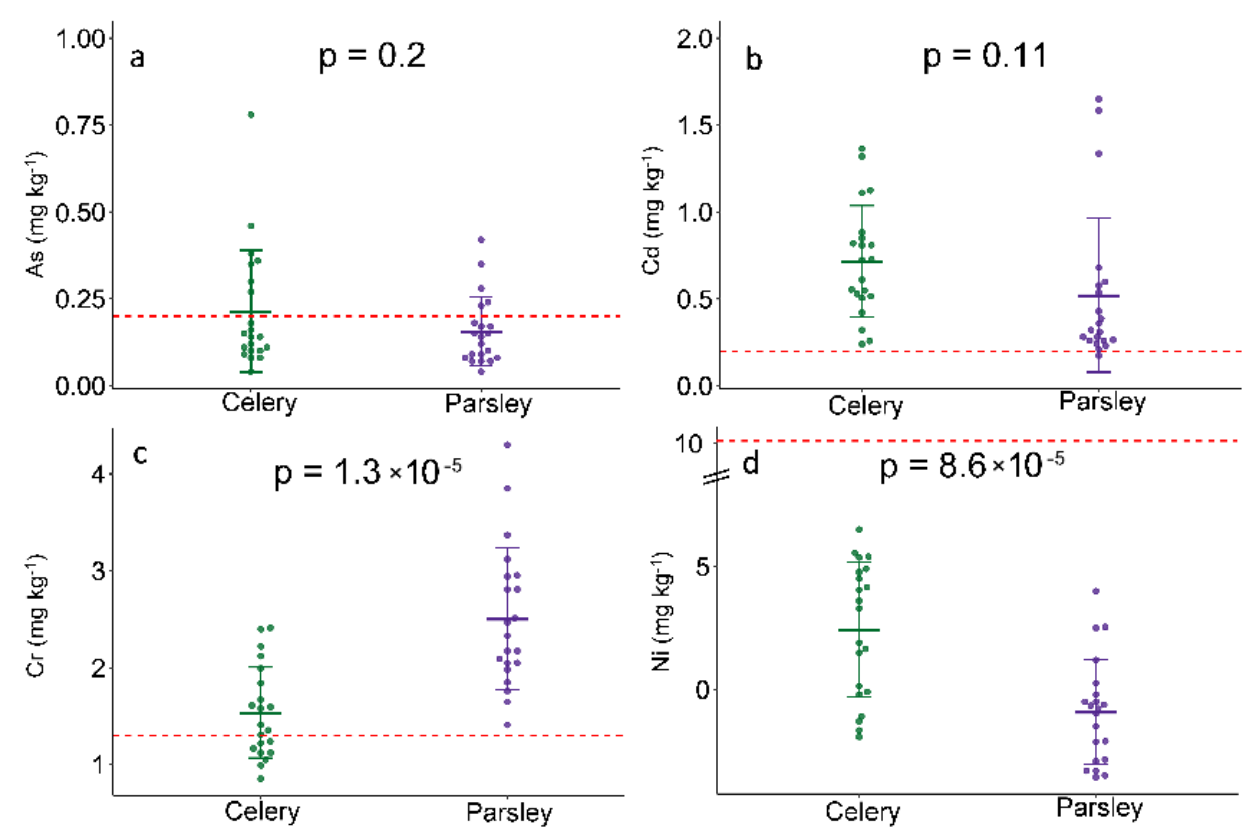
Figure 1. Trace elements concentration in celery and parsley root: ( a ) arsenic; ( b ) cadmium; ( c ) chromium; ( d ) and nickel content (mg/kg dry mass). Data are presented as the mean ± standard deviation. Unpaired t -test was used for comparing the means between species ( n = 21) and the p -value is assigned to each plot, p ≤ 0.05 has been considered as significant. Red dashed line indicates maximum allowable concentration (MAC) for the corresponding element: As–0.2; Cd–0.2; Cr–1.3; Ni–10 mg/kg.